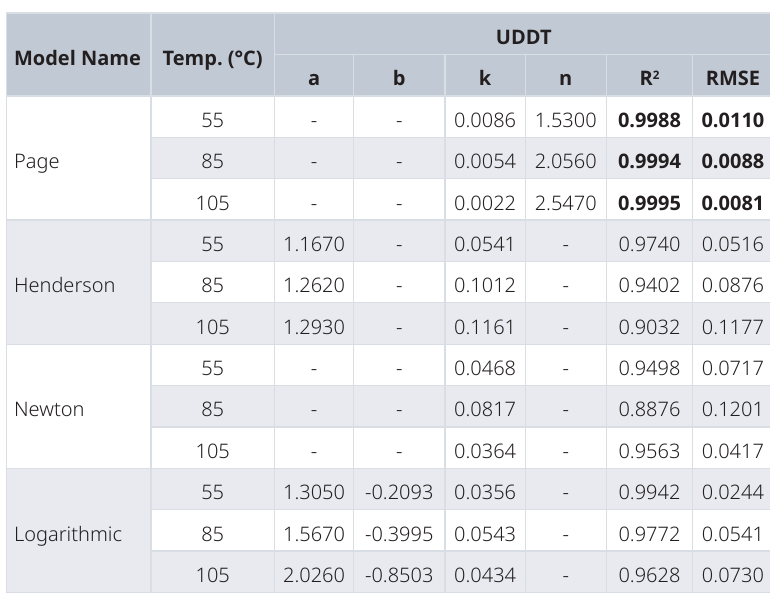
Table 5. Statistical data for isothermal drying of urine-diverting dry toilet (UDDT).